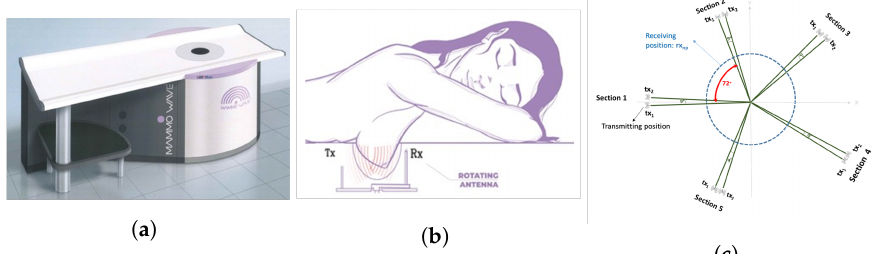
Figure 2. ( a ) MammoWave device designed by Umbria Bioengineering Technologies (UBT), Italy. ( b ) Patient’s breast examination procedure with MammoWave. ( c ) Pictorial view of the transmitting- receiving antenna positions of MammoWave